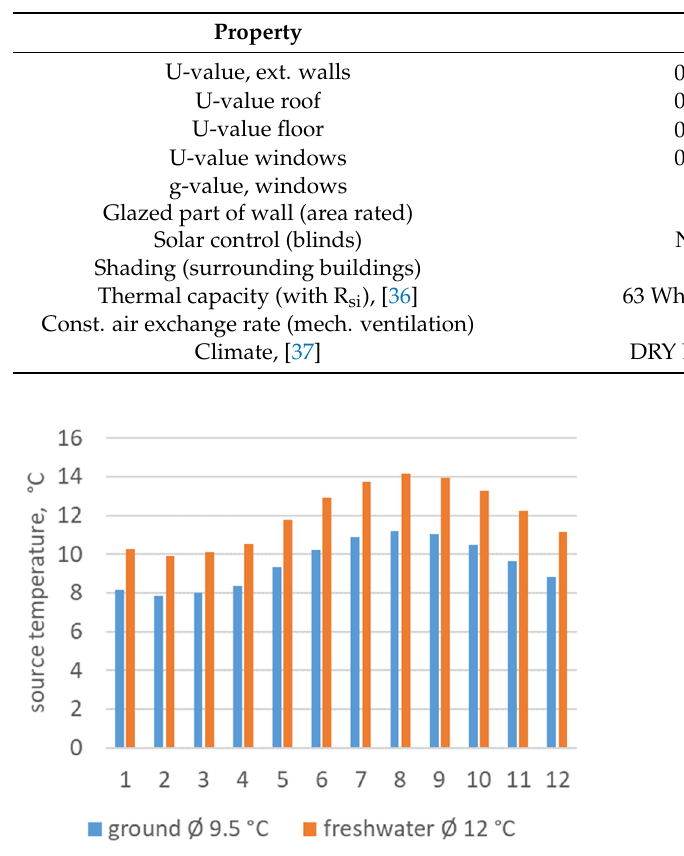
Table 1. Properties of the residential building [35].